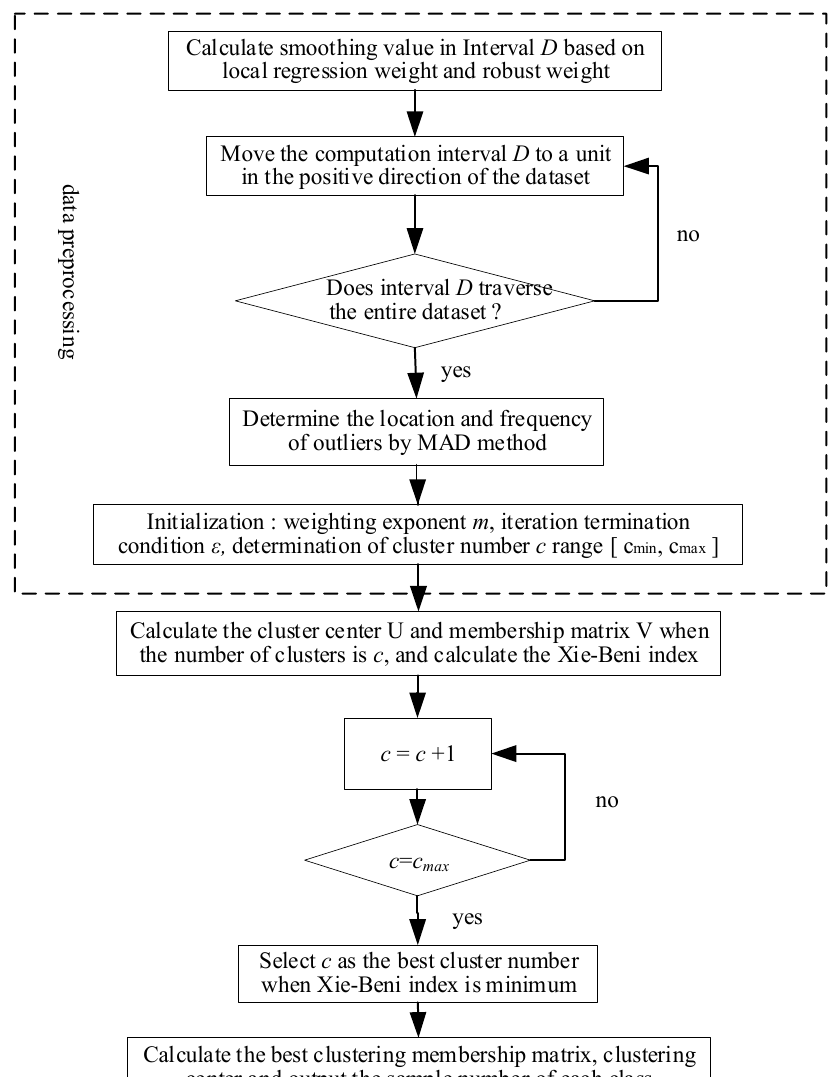
Figure 1. Local regression FCM algorithm flow chart.